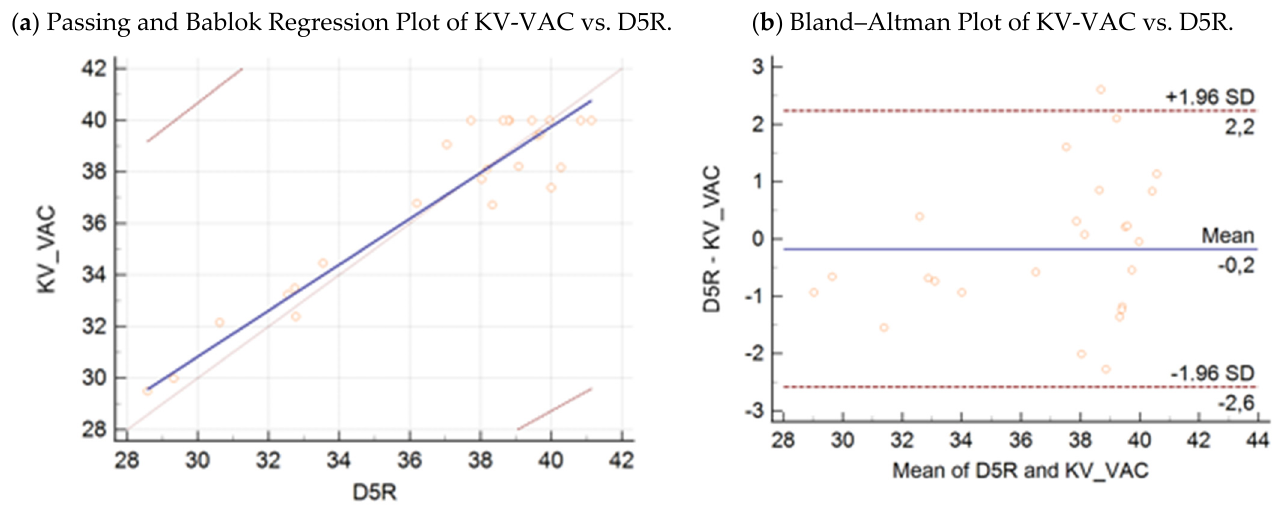
Figure 5. ( a ) Passing–Bablok regression plot: comparison of Ct values obtained with the KV-VAC strain assay vs. Capripox- specific real-time PCR D5R assay, with 95% CI in 25 samples. ( b ) Bland–Altman plot: comparison of Ct values obtained